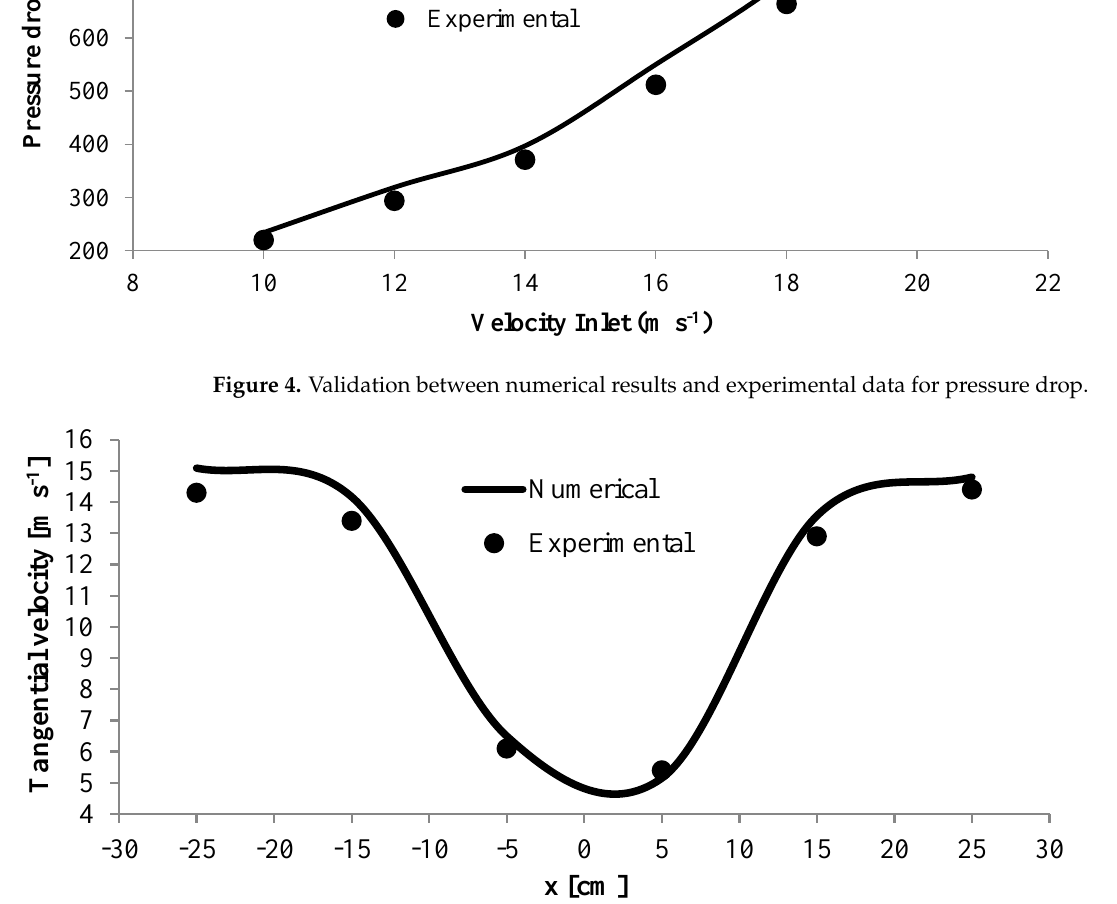
Figure 6. To better compare the inlet velocity efficacy on various parameters, the rainbow value index is fixed in various inlet